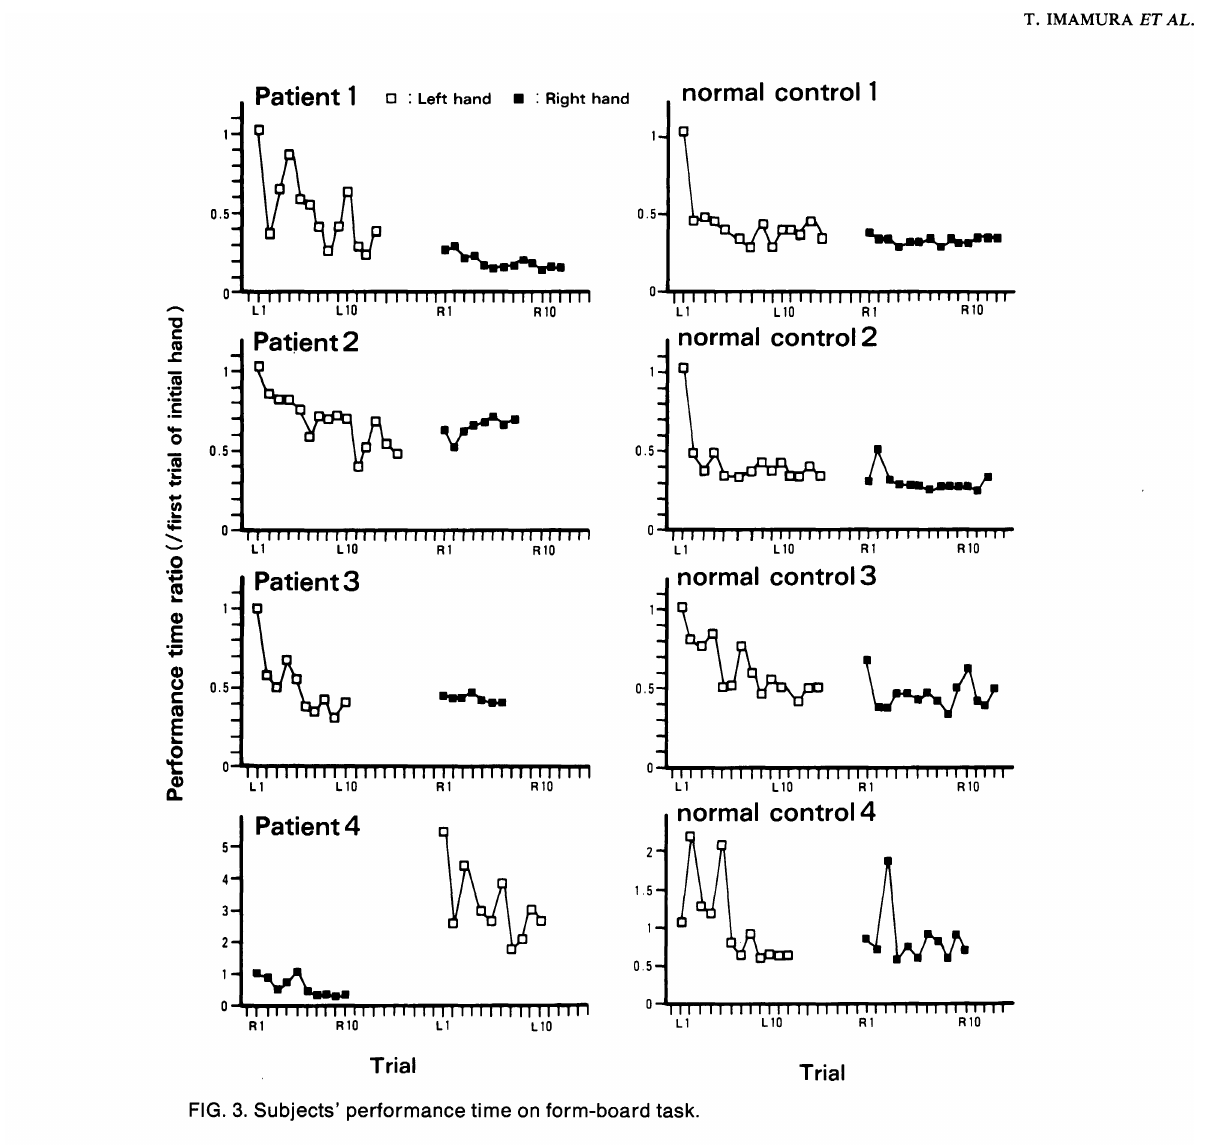
FIG. 3. Subjects' performance time on form-board